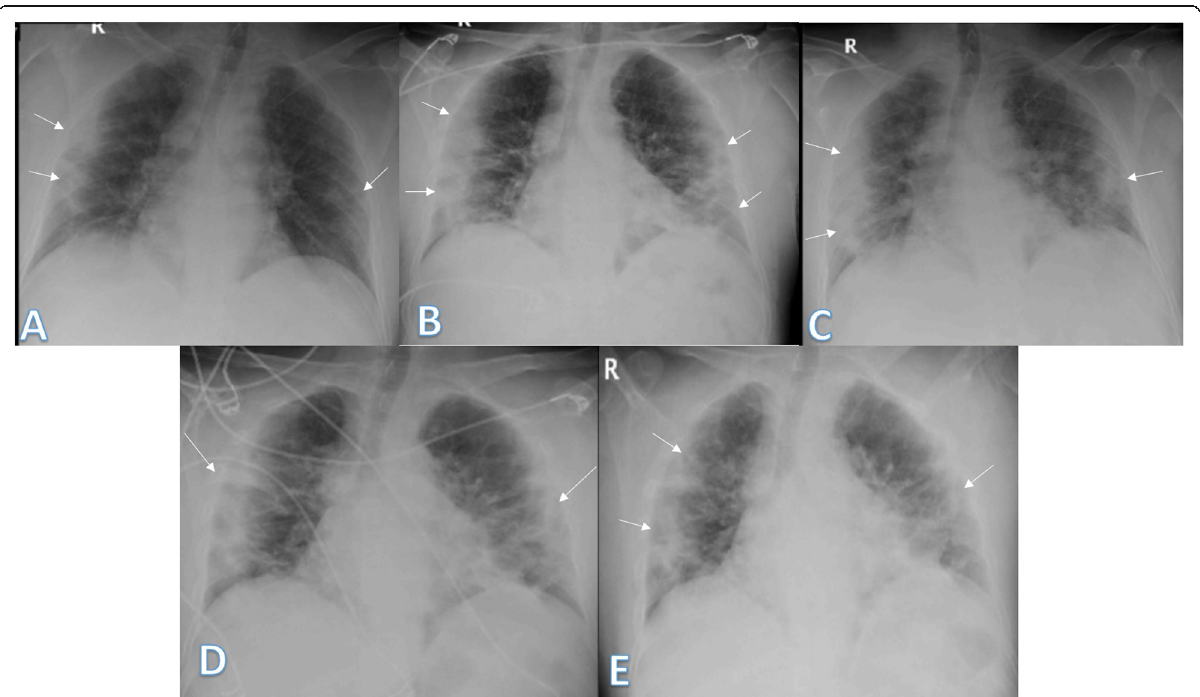
Fig. 15 52-year male with positive COVID-19 virus. Initial chest X-ray ( a ) showed air space consolidation opacities at the periphery of the mid and lower zones of the right lung and small patch at the left lower lung zone (arrows) with TSS 3 (2 on the right side and 1 on the left side). On the